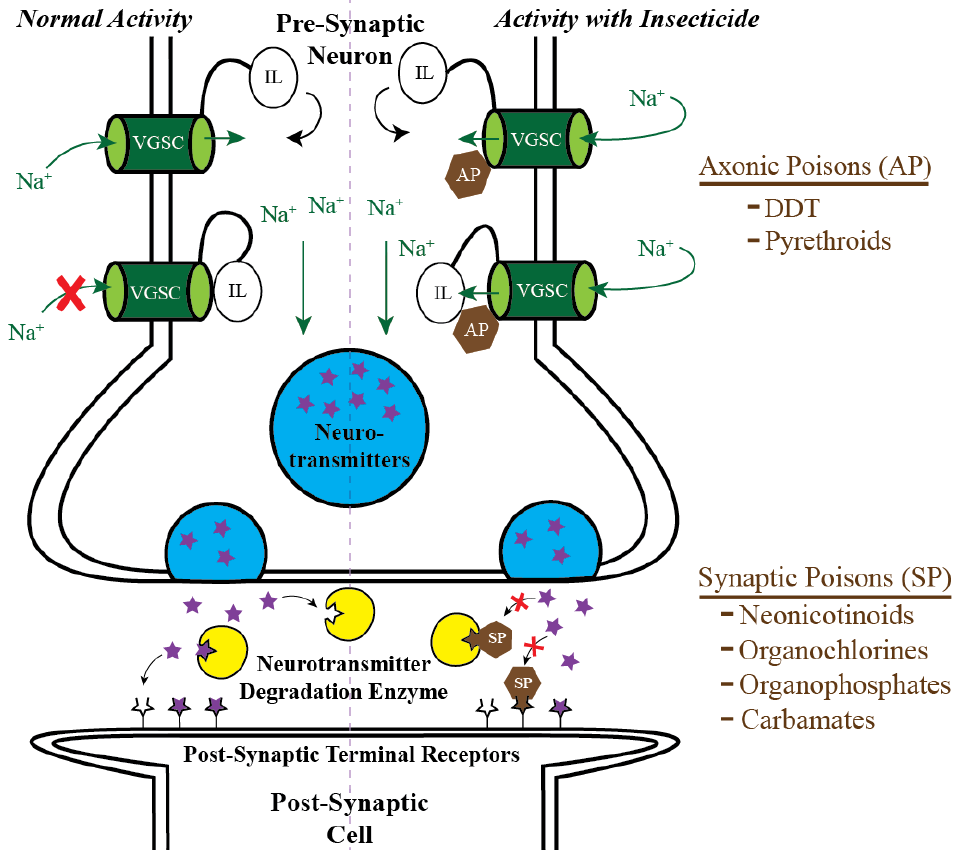
Figure 1. Neurotoxic insecticides can be classified as axonic poisons or synaptic poisons. Axonic poisons (AP) bind voltage gated sodium channels (VGSC) and their inactivation loop (IL), thereby altering the movement of sodium ions and disrupting the transmission of action potentials. Synaptic poisons (SP) either prevent enzymes from degrading neurotransmitters or interfere with the binding of neurotransmitters to their post-synaptic terminal receptors, thereby disrupting the communication between presynaptic neurons and post-synaptic cells.